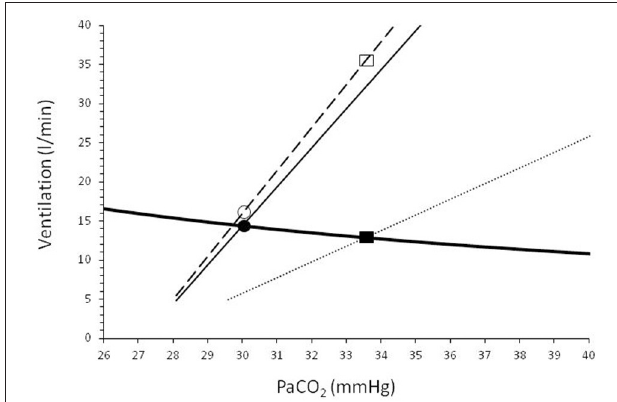
FIGURE 2 | Graphical representation of the metabolic hyperbola (solid heavy line) and brain/ventilation curve of a patient with COVID-19 pneumonia. CO 2 production and dead space to tidal volume ratio were considered higher than normal (V’CO 2 : 250 ml/min, V D /V T : 0.5). Dashed line shows brain curve. Ventilation curves at two values of respiratory system compliance, are shown by solid (slightly reduced compliance) and dotted (low compliance) lines. The intersection of the metabolic hyperbola and ventilation curve determines the steady-state PaCO 2 . Early in the disease, where phenotype 1 may prevail (slightly reduced compliance), the deviation between brain and ventilation curve is small and, as a result, the actual PaCO 2 is slightly higher than the desired PaCO 2 (30.0 vs. 29.6 mmHg). The increased activity of respiratory center as a result of this small difference between actual and desired PaCO 2 increases the ventilatory demands to 16.0 l/min (open circle), only 1.2 l/min higher than the actual minute ventilation (V’ E , 14.8 l/min, closed circle). Later in the disease compliance decreases (i.e., type 2 phenotype prevails), causing a greater deviation between brain and ventilation curve. PaCO 2 increases to 33.5 mmHg and actual V’ E decreases to 12.8 l/min (closed rectangular). At this level of PaCO 2 the brain curve dictates (open rectangular) that respiratory center activity corresponds to V’ E of 35.2 l/min. This high respiratory center activity combined with unmet ventilatory demands (35.2–12.8 = 22.4 l/min) causes severe dyspnea and respiratory